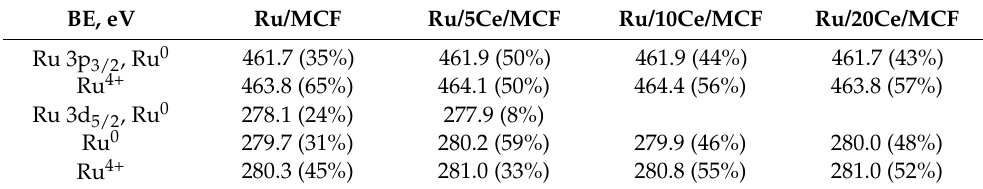
Table 3. XPS results obtained from the Ru 3p 3/2 and Ru 3 d 5/2 regions.